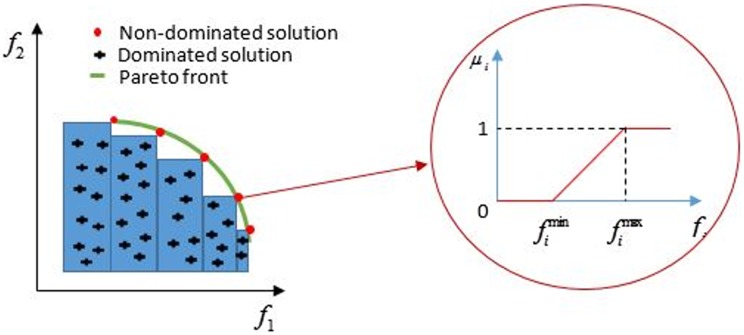
Fuzzy set mechanism (adopted from [54]).